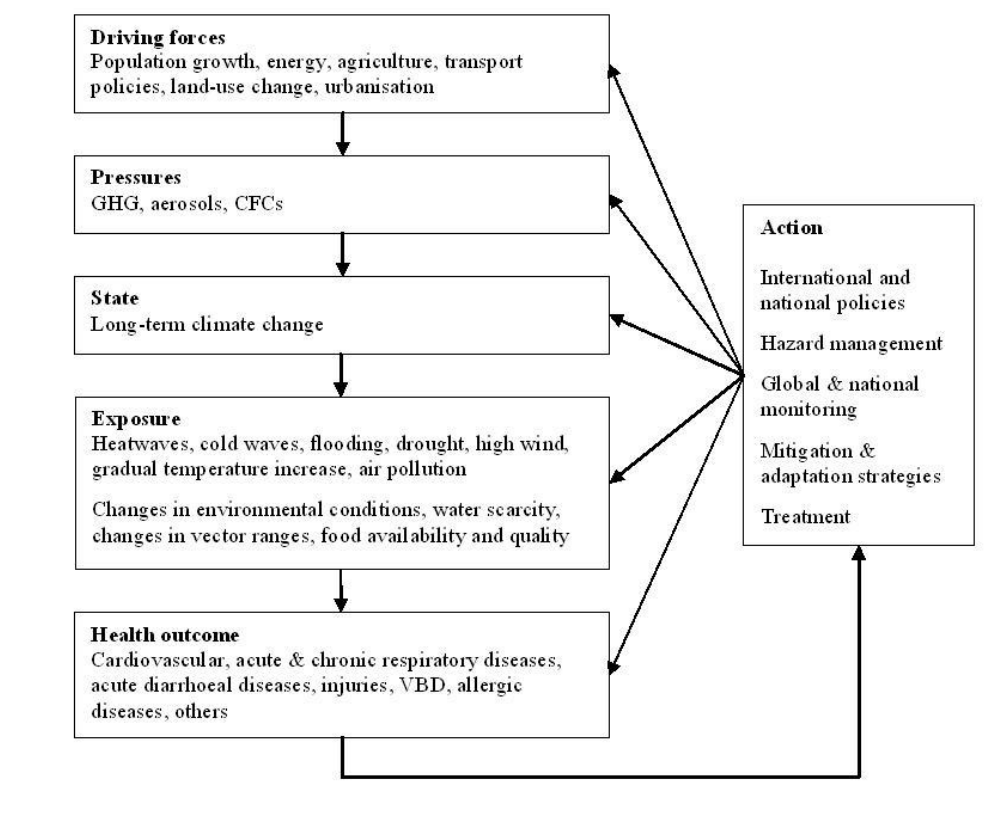
Figure 5. Driving force-Pressure-State-Exposure-Effect-Action framework applied to climate change